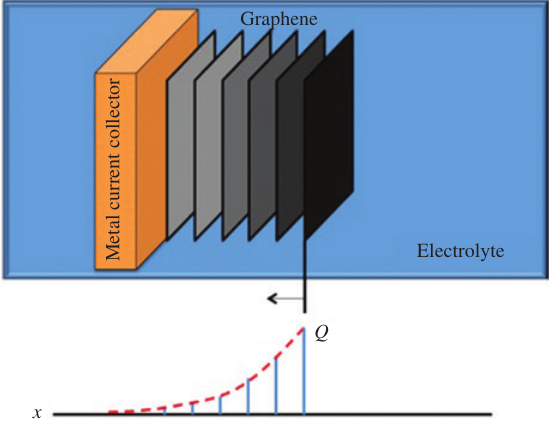
screened into the other interior layers of the 2D mate- rial. Alternately, a single-layered 2D material (e.g. SLG) would not have a spread of charge into the interior and no C . This would help in the further delineation of the SC constituents of the measured capacitance. Generally, the consideration of C would also be very relevant for SC Mo P, etc.). 2